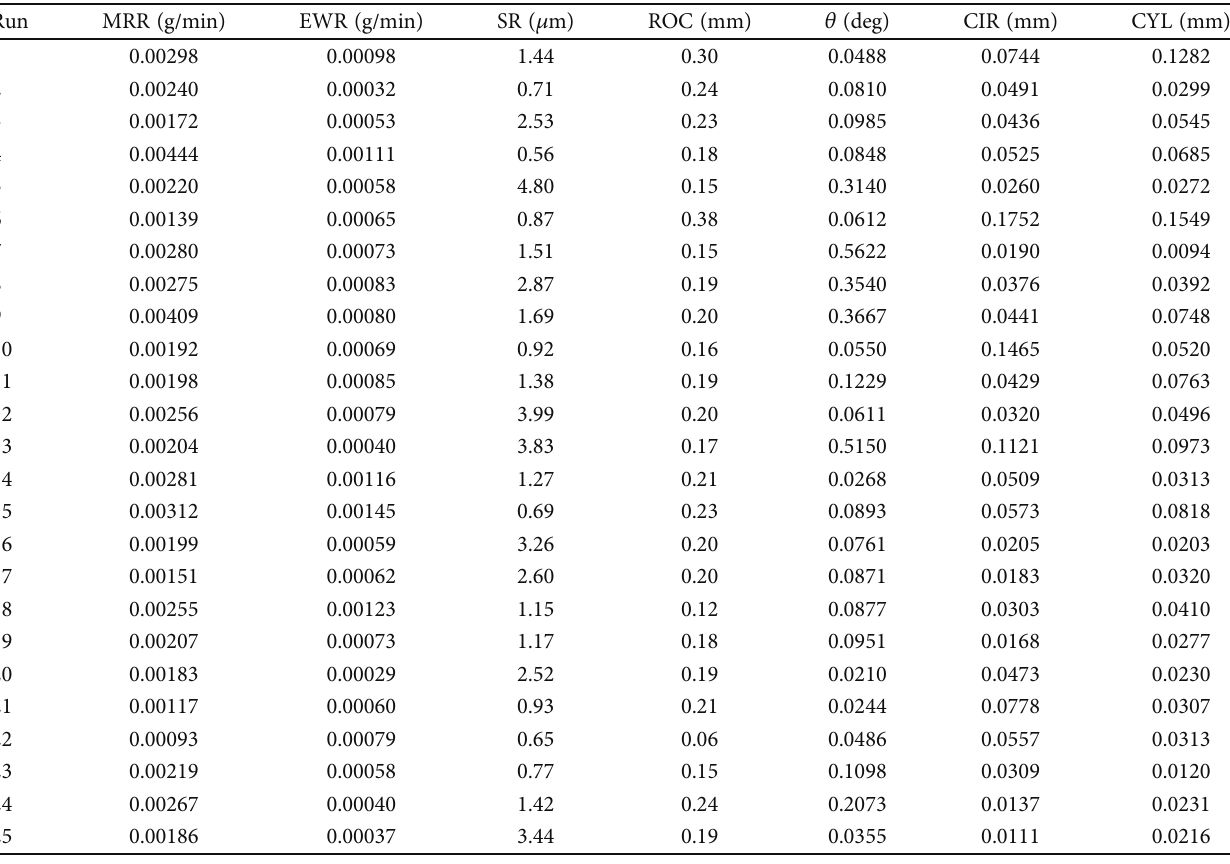
Table 3: Experimental results for responses after